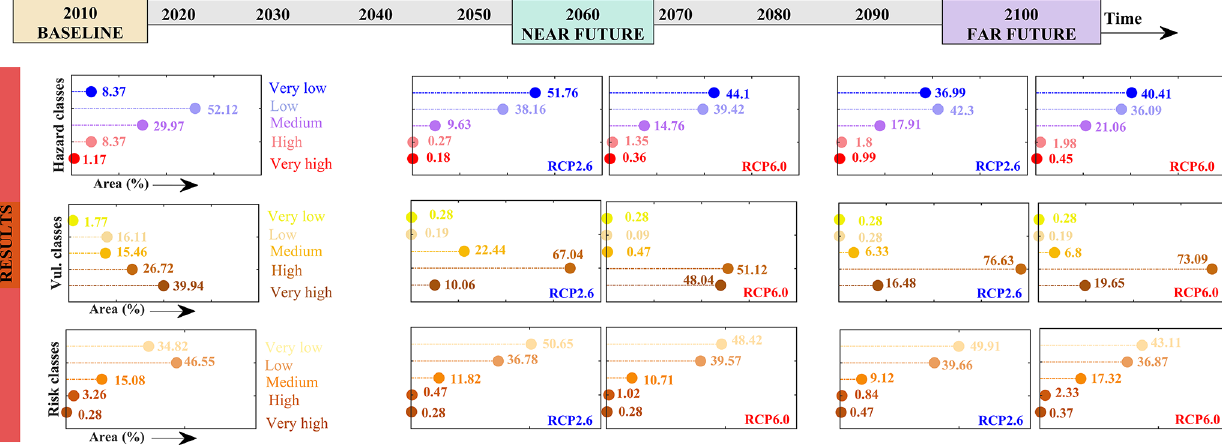
Figure 10. Summary of drought risk evolution. Percent area of different classes of drought hazard, vulnerability and risk under various climate and socio-economic